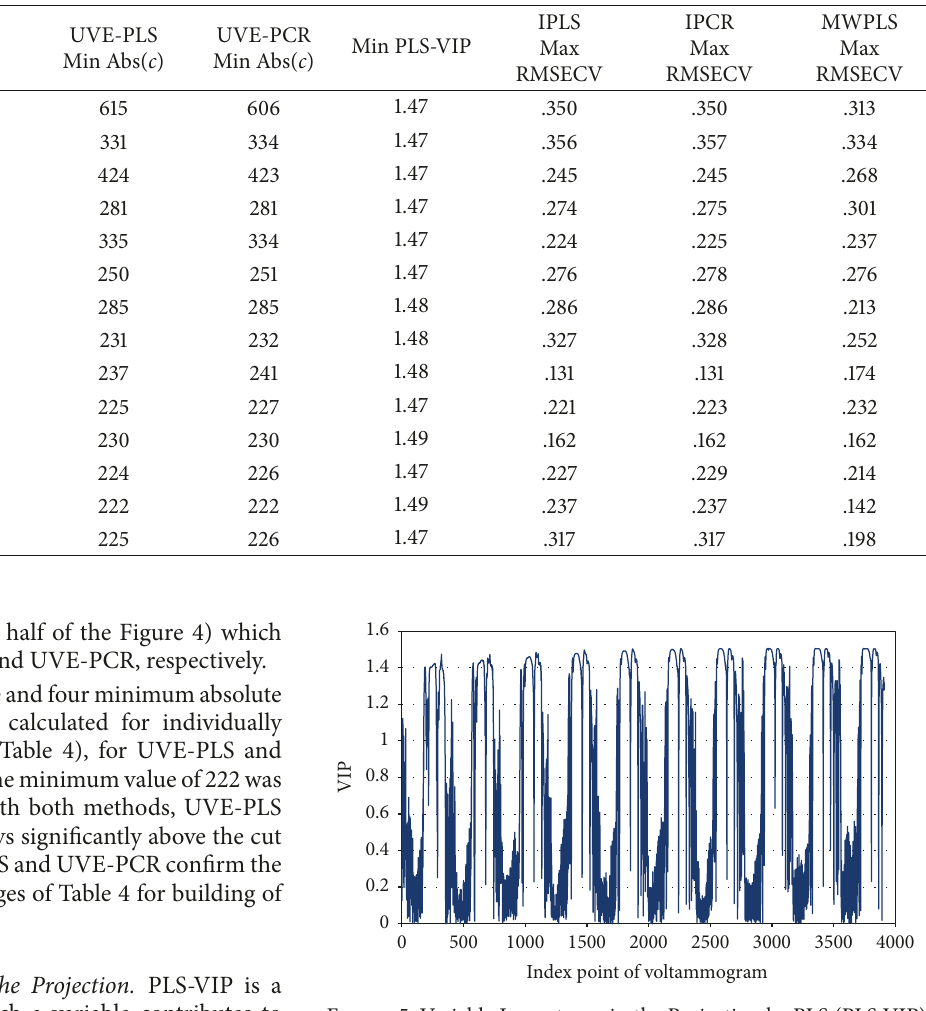
Figure 5: Variable Importance in the Projection by PLS (PLS-VIP) (see (8)) calculated for 𝐽 = 3911 points of autoscaled voltammograms for 𝐹 = 1